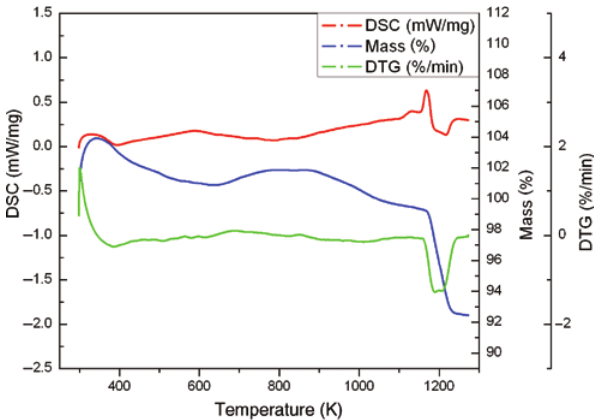
Figure 4: TGA, DTG, and DTA curves for the precursors